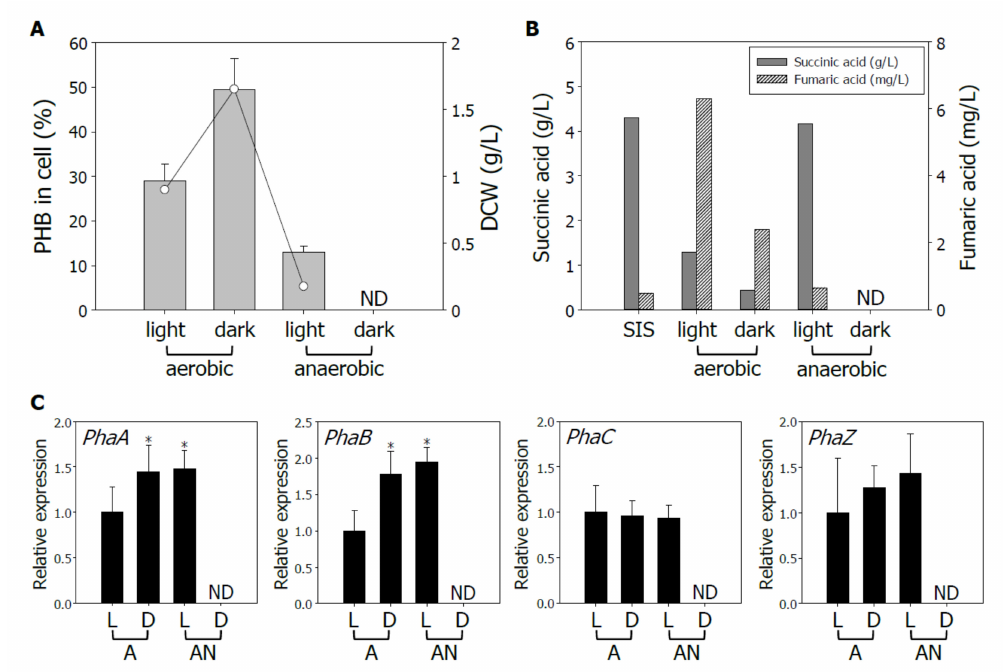
Figure 1. Effects of light and aeration on polyhydroxybutyrate (PHB) production in R. sphaeroides . ( A ) PHB accumulation (% of dry cell weight) and cell growth. The samples were harvested at 48 h after inoculation. Gray bars for PHB contents and open circle lines for dry cell weight (DCW). ( B ) Measurement of organic acids concentrations. SIS, Sistrom’s medium. ( C ) Expression of genes encoding PHB biosynthetic enzymes. PhaA , acetyl-CoA acetyltransferase (RSP_0745); PhaB , acetoacetyl-CoA reductase